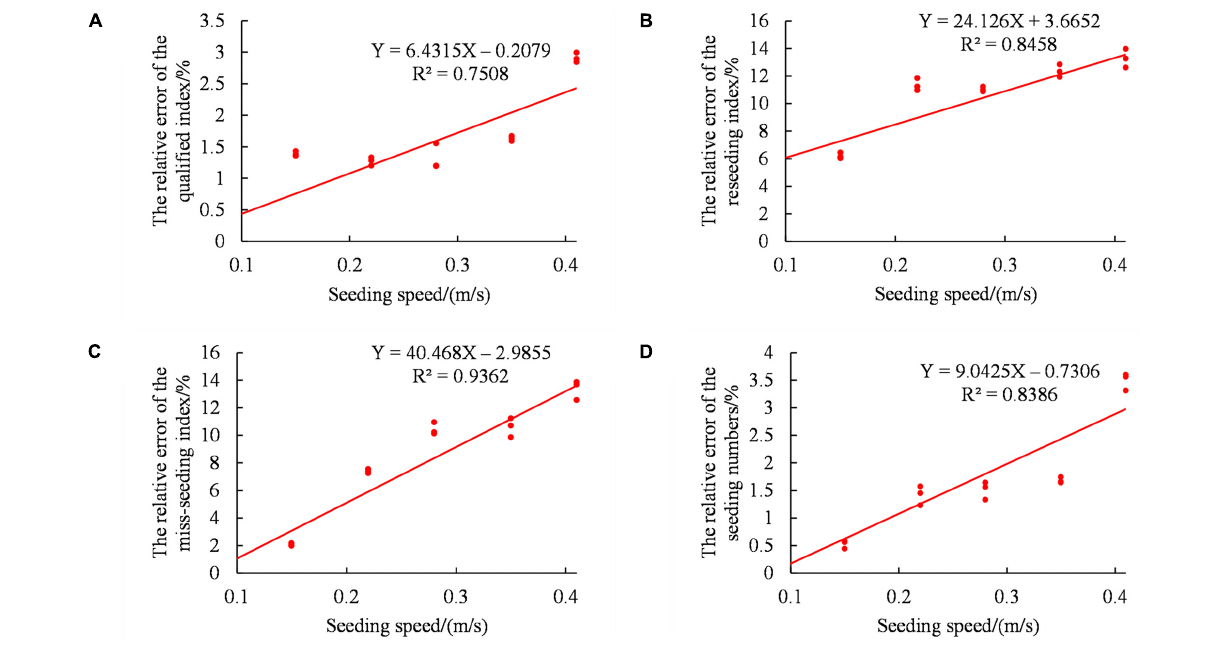
Frontiers in Plant Science |